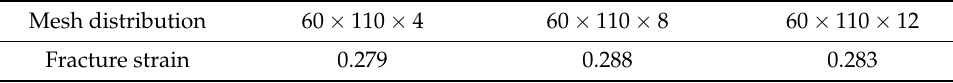
Table 2. Effect of mesh on facture